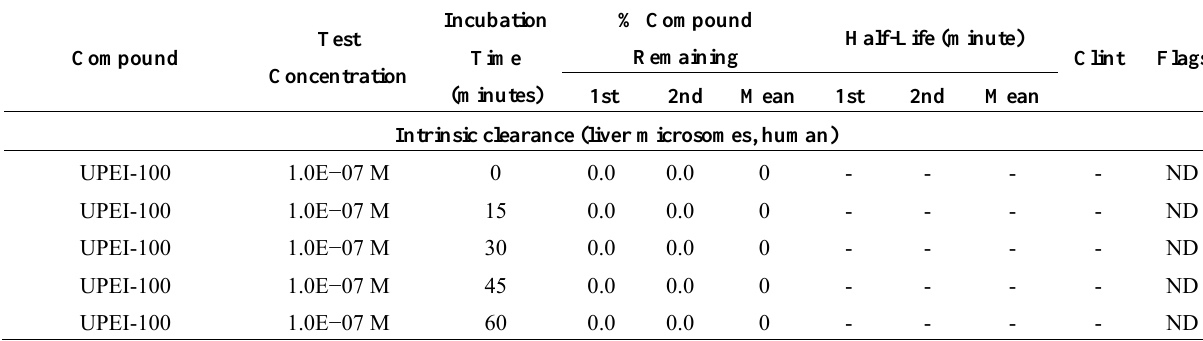
Table 3. Metabolic stability/intrinsic clearance ( CL int ) of UPEI-104 and UPEI-100 in human liver